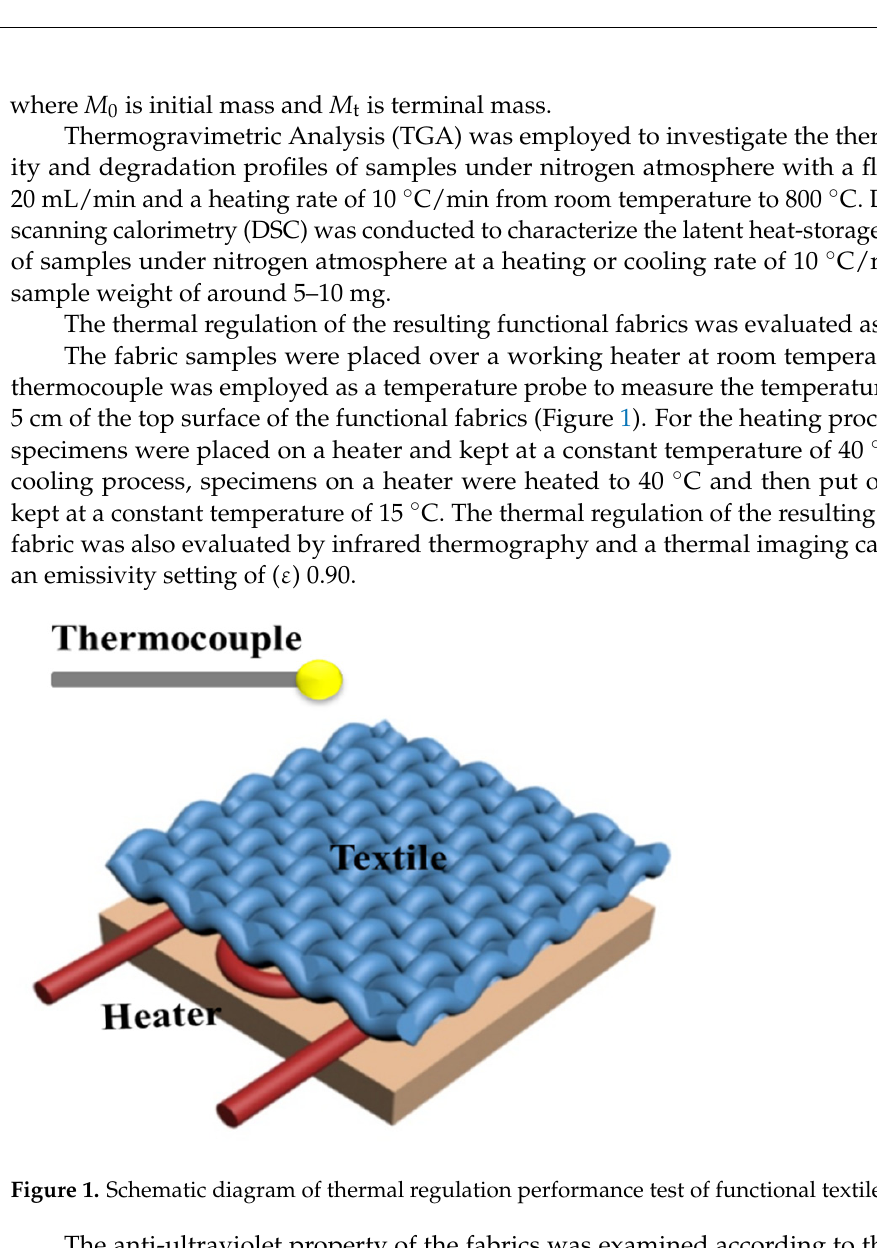
Figure 1. Schematic diagram of thermal regulation performance test of functional textiles.